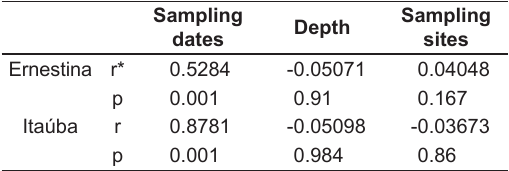
Figure 8. (a) non-metric multidimensional scaling (NMDS) scatter plot of phytoplankton data from Ernestina reservoir. Sampling units are indicated by numbers: (January 2012) empty circle, (May 2012) empty square, (September 2012) full circle, (February 2013) triangle; (b) non-metric multidimensional scaling (NMDS) scatter plot of phytoplankton data from Itaúba reservoir. Sampling units are indicated by numbers: (January 2012) empty circle, (May 2012) empty square, (September 2012) full circle, (January 2013) Table 4. Similarity index (r) and significance (p) given by the analysis of similarity (Anosim) between sampling dates, depths and sampling sites in Ernestina and Itaúba reservoirs.